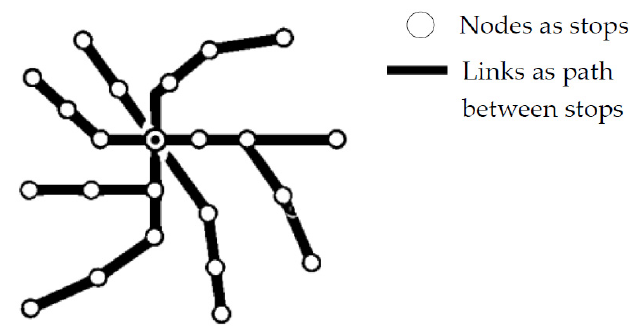
Figure 1. Example of the representation of a transport network.